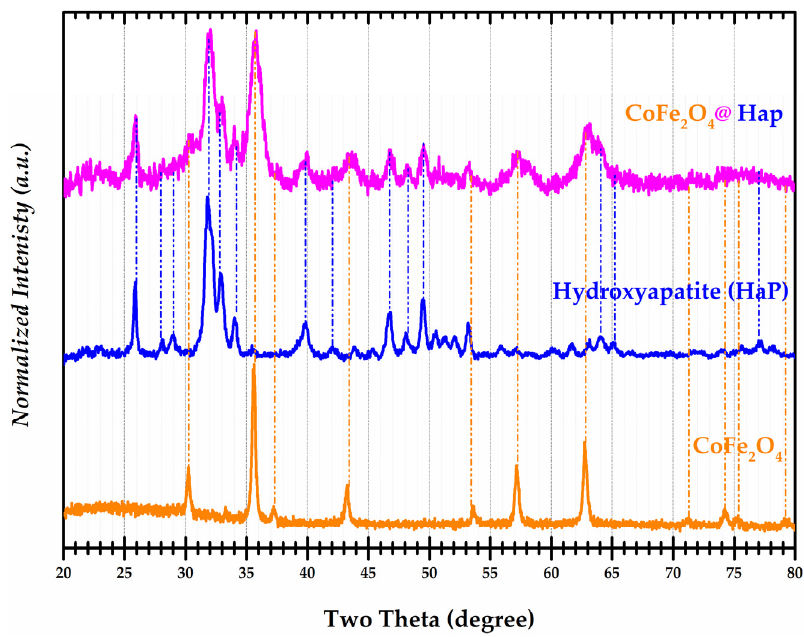
Figure 3. Normalized X-ray diffractograms for samples of Hydroxyapatite (HaP), CoFe 2 O 4 @HaP, and CoFe 2 O 4 .